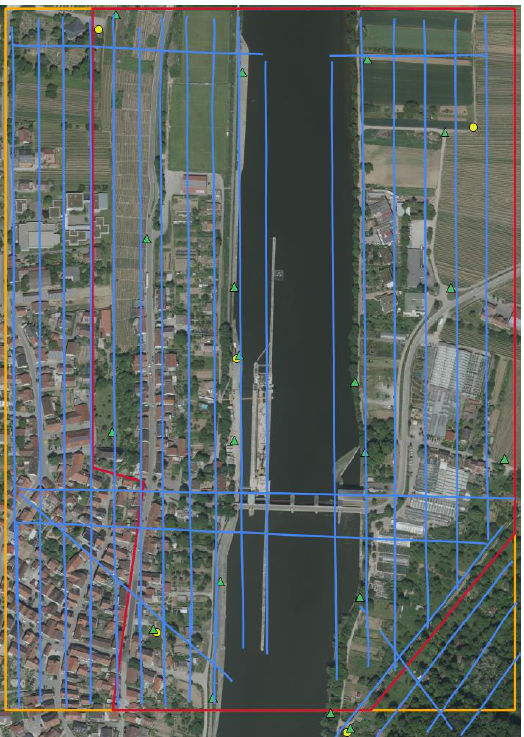
Figure 2. Area of investigation in Hessigheim, Germany (red: for photogrammetry, orange: for LiDAR).